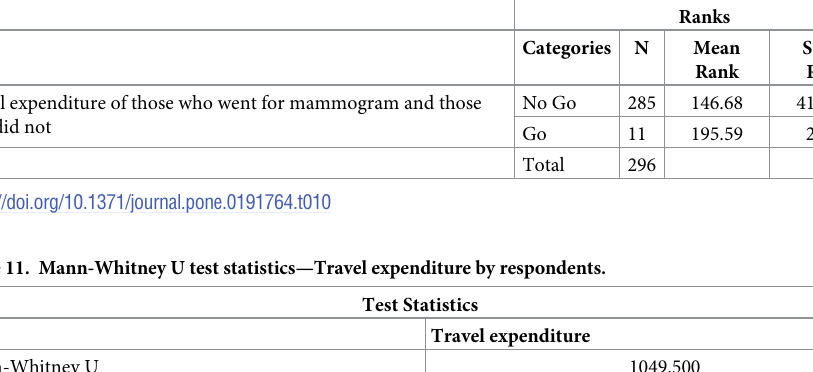
Table 10. Mann-Whitney U mean ranks table—Travel expenditure by respondents.